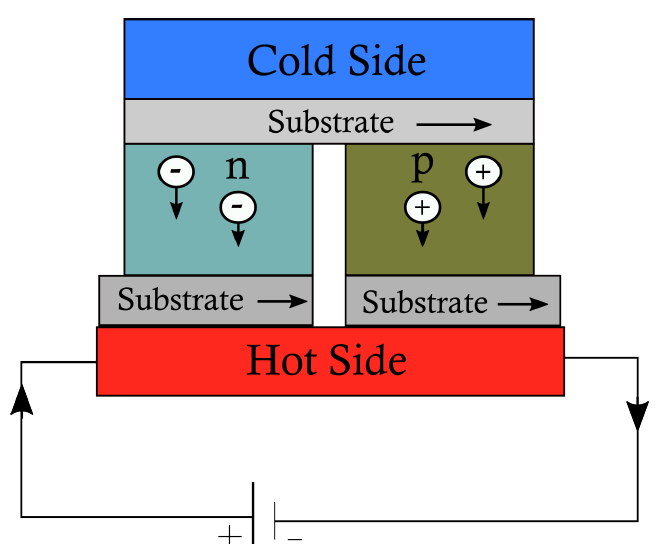
Figure 2. Schematic diagram of a typical thermoelectric module (adapted from